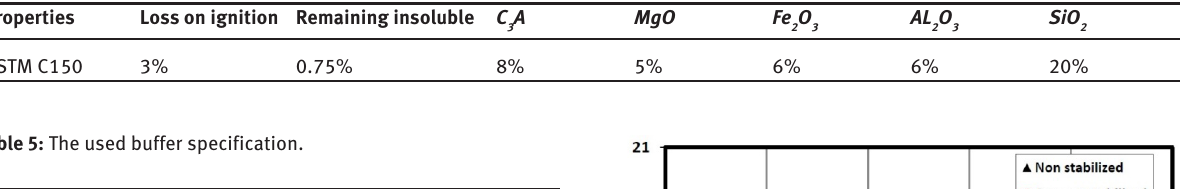
Degree of acidityEnvironmental condition